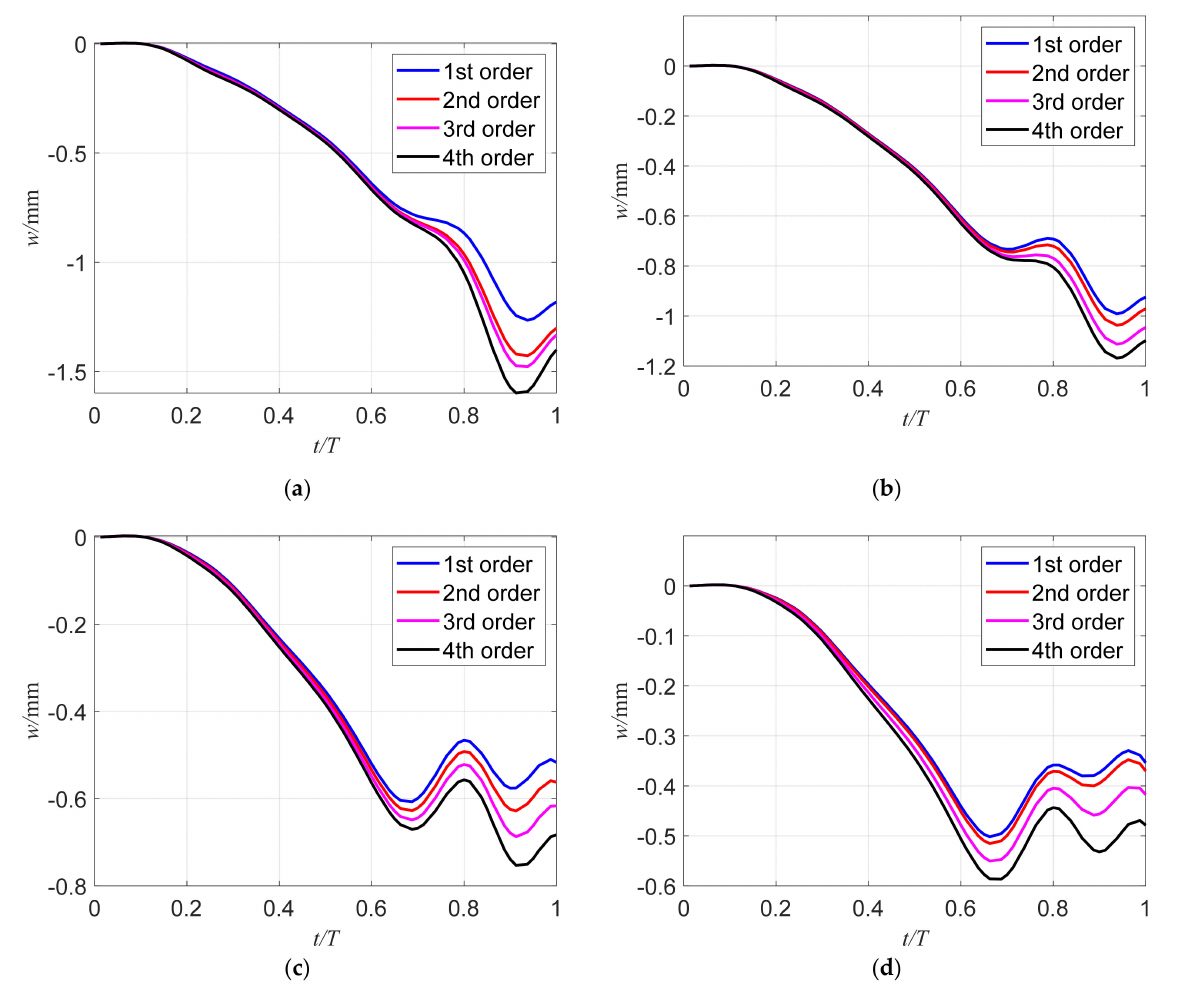
Figure 7. Dynamic response of the partially covered plate with different patch sizes after first four order damping loss factor optimization for CFFF. ( a ) 0.04 m × 0.04 m; ( b ) 0.08 m × 0.08 m; ( c ) 0.16 m × 0.04 m; ( d ) 0.16 m × 0.16